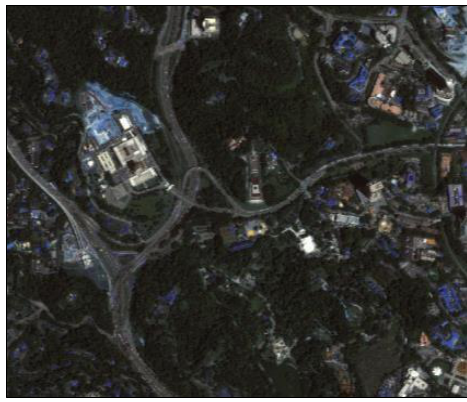
Figure 1: Pleiades imagery of National Monument Park,